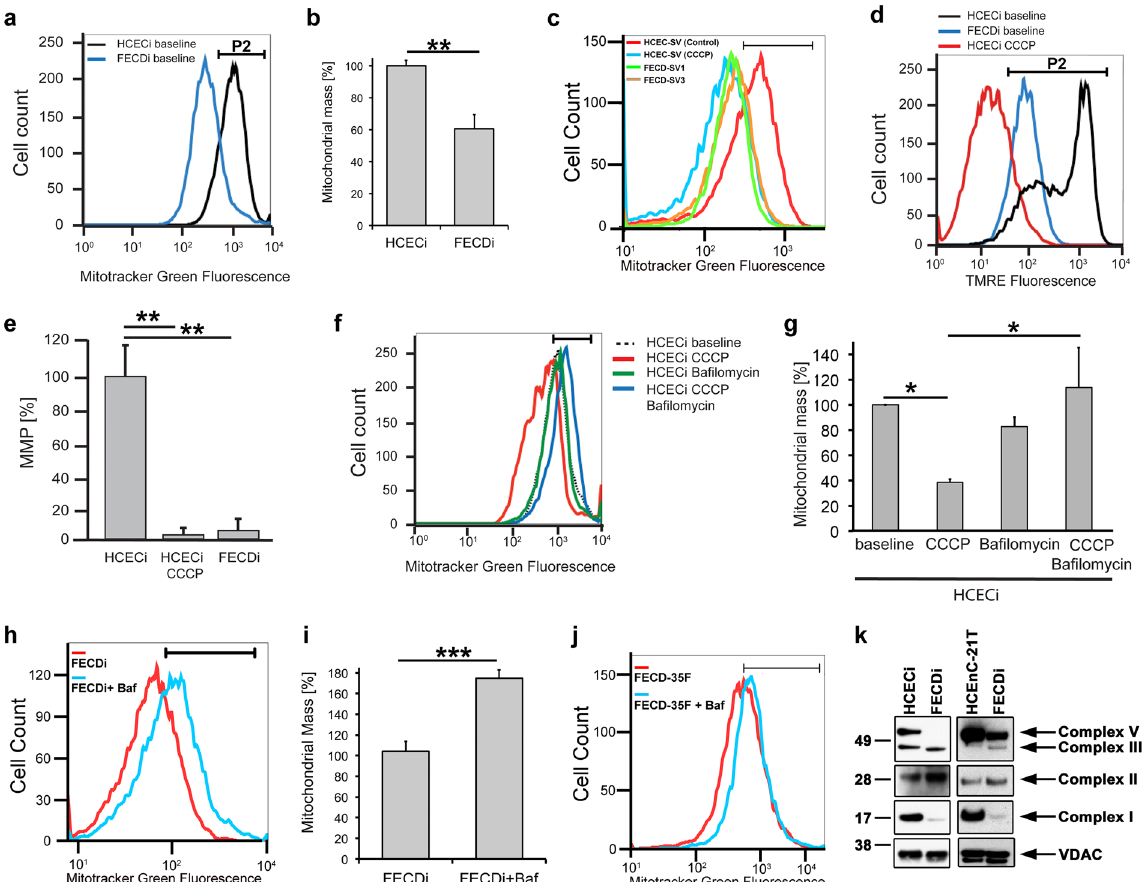
Figure 1. FECD cell lines exhibit decreased mitochondrial membrane potential and mass. ( a ) Representative histogram of Mitotracker Green FM fluorescence intensity plotted against number of cells shows decreased mitochondrial mass in FECDi within the population of cells present in gate P2. ( b ) Quantification of mitochondrial mass from three independent experiments in FECDi. Bars show average percentage of cells in gate P2 ( + SEM) from three experiments with HCECi normalized to 100%. ( c ) Two FECD (FECD-SV1 and –SV3) and one normal (HCEC-SV) corneal endothelial cell lines generated with SV40 transduction shows reduced mitochondrial mass in FECD-SV1 and –SV3 that overlaps 20 μ M CCCP-treated HCECi-SV. ( d ) Flow cytometry analysis of mitochondrial membrane potential ( ∆ Ψ m) measured by TMRE in HCECi and FECDi. HCECi treated with 20 μ M CCCP resulted in the abrogation of ∆ Ψ m in HCECi that is comparable to FECDi. ( e ) Bars represent average percentage of cells in gate P2 ( + SEM) from three independent experiments. ( f , g ) Flow cytometry analysis and quantification of mitochondrial mass in HCECi treated with 20 μ M CCCP, 10 nM bafilomycin, or both with Mitotracker Green FM. Mitochondrial mass in HCECi is reduced with CCCP and is rescued by bafilomycin. ( h ) FECDi cells treated with 10 nM bafilomycin for 16 h shows an increase in mitochondrial mass and quantified from three independent experiments in ( i ). ( j ) Mitochondrial mass is also increased in FECD primary cells (FECD-35F) treated with bafilomycin. ( k ) Western blot of whole cell lysates from two normal (HCECi and HCEnC-21T) and FECDi cell lines shows absence of complex I and V of the electron transport chain in FECDi. VDAC was used as a loading control. Student’s t -test was performed to test the statistical significance. * P < 0.05, ** P < 0.01, *** P <